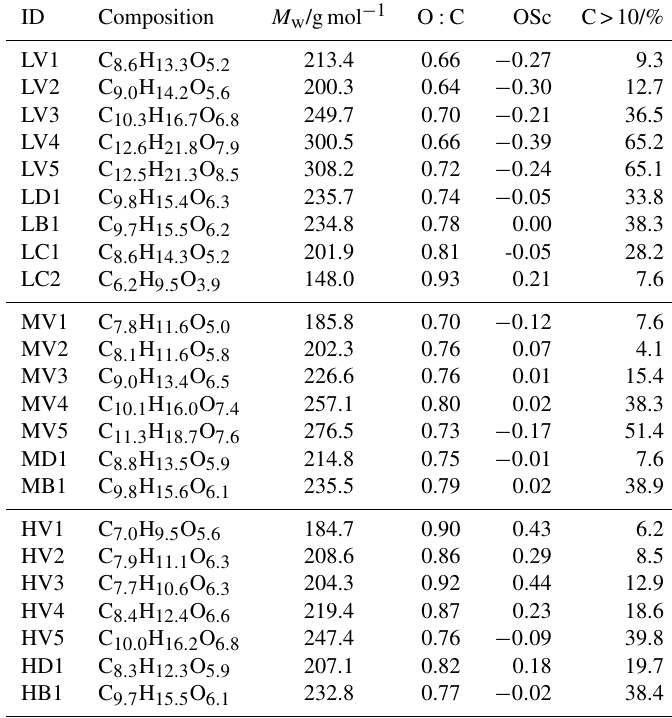
Table 1. Signal-weighted average values of elemental composition, O : C, OSc, and the contribution of C>10 compounds for all factors.